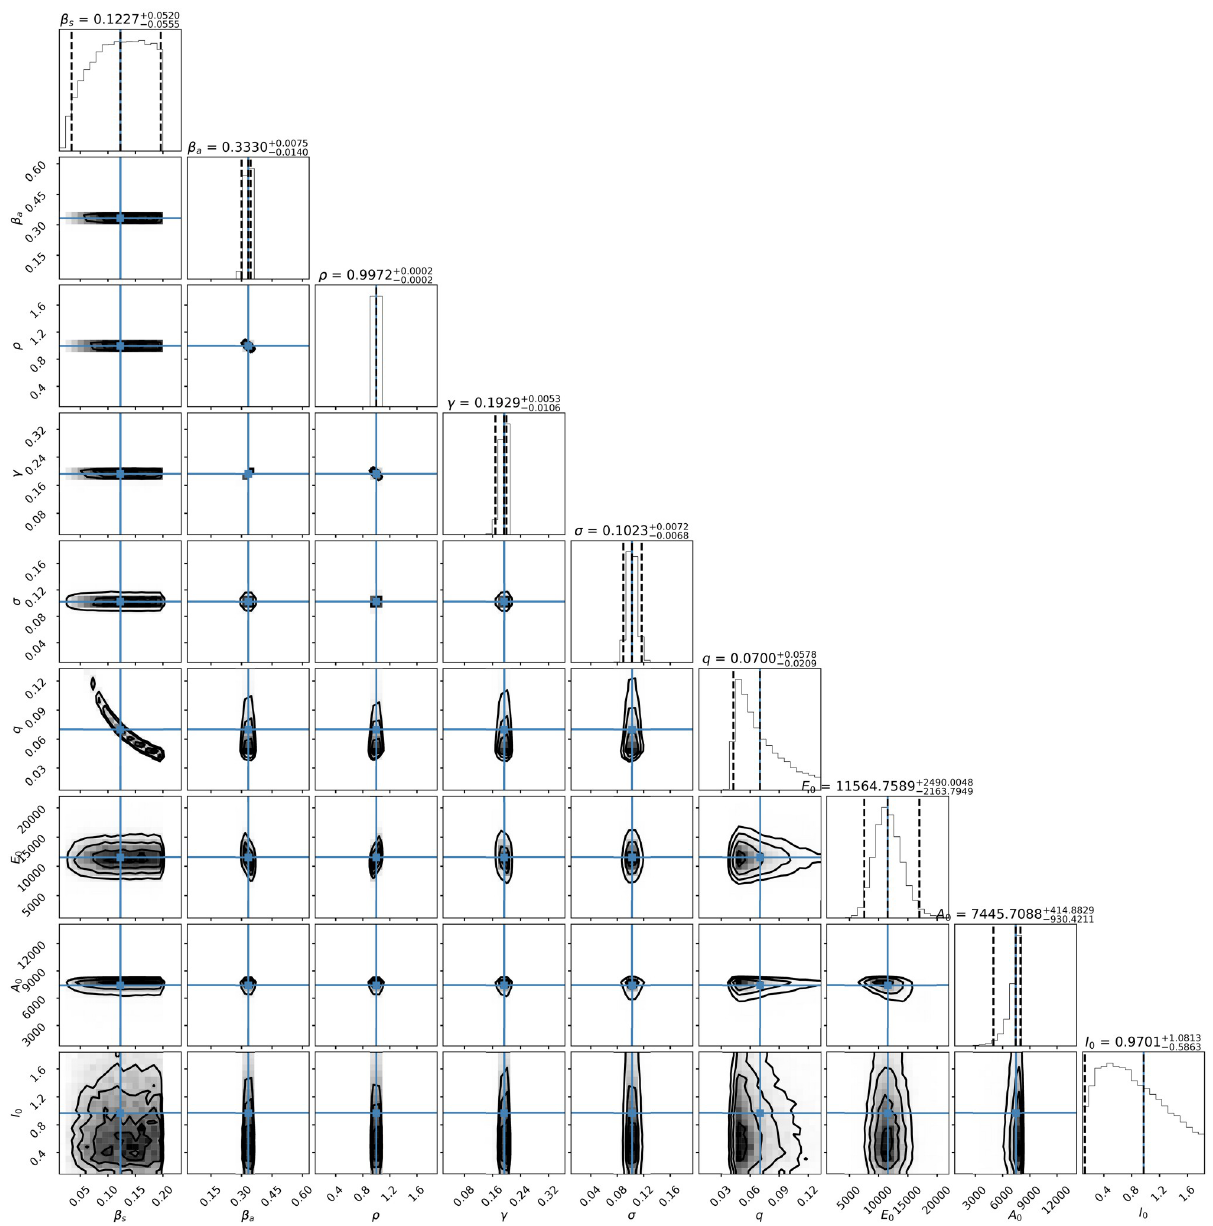
Fig 3. Joint probability density distributions of the estimated parameters. Joint probability density distributions of parameters of model (1) within 95% HPD using the Stan Package [63]. The blue lines represent the medians.